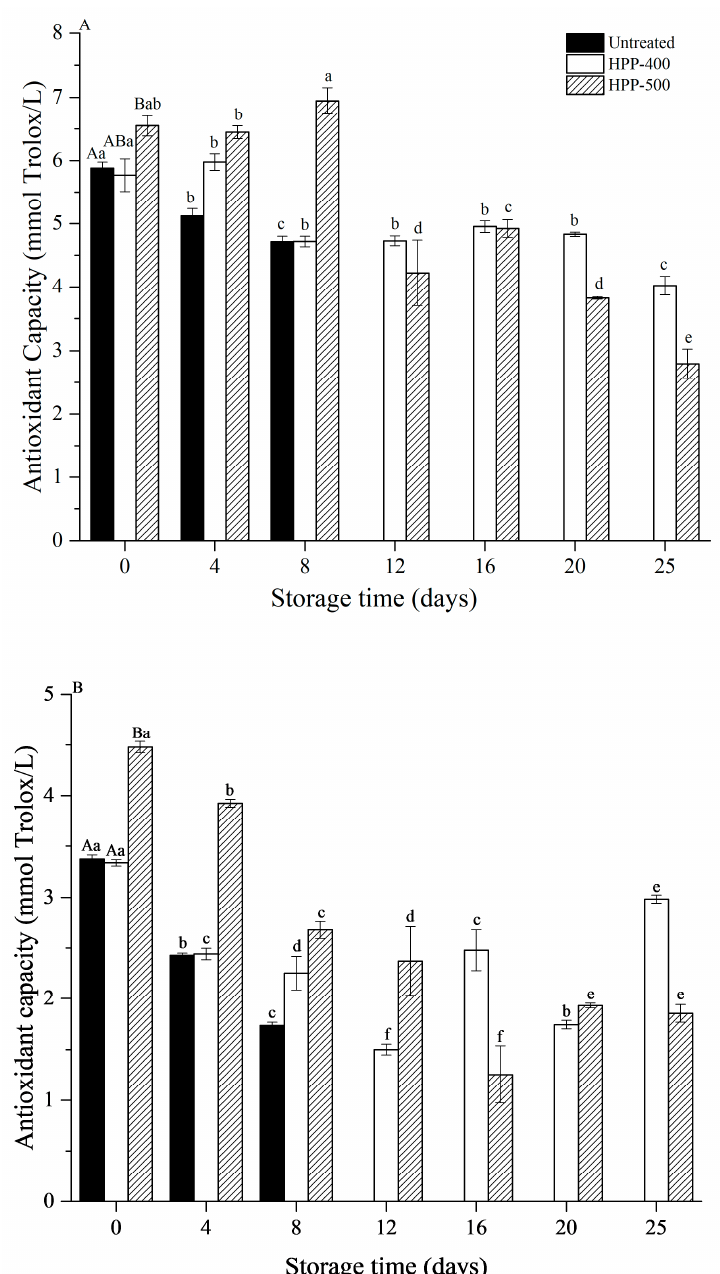
Figure 3. Changes in the antioxidant capacity (DPPH ( A ) and FRAP ( B )) of fresh-cut bell pepper during storage at 4 °C. The capital letters within one column show significant differences at day 0 ( p < 0.05). Values with different letters within one column are significantly different during storage ( p < 0.05).